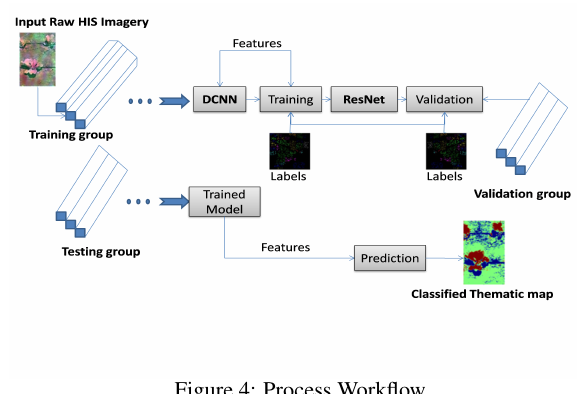
Figure 4: Process Workflow